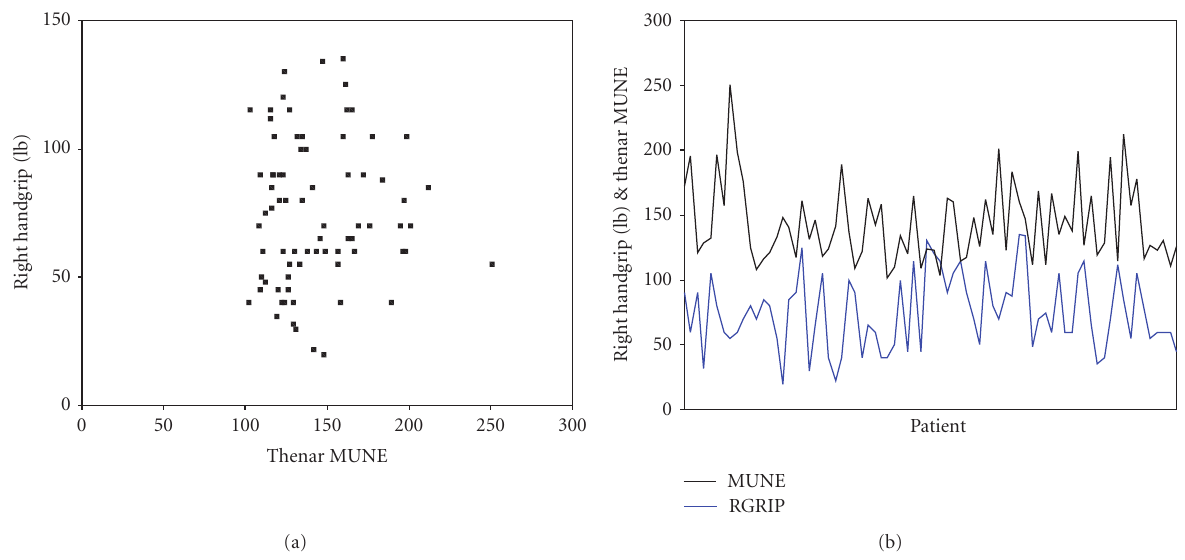
Figure 3: Scatter and line graph showing the lack of correlation between right handgrip and thenar (APB) MUNE.